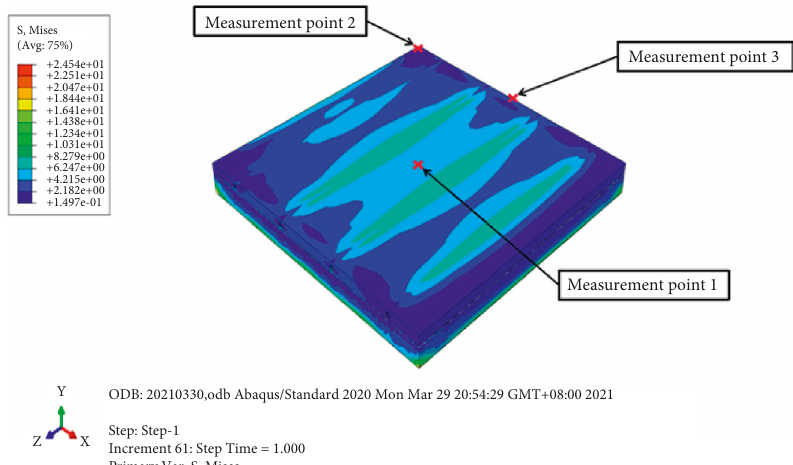
Figure 12: Temperature stress cloud.